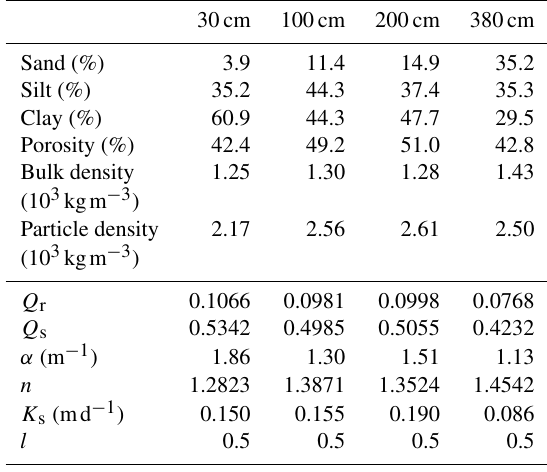
Table 2. Soil physical properties and van Genuchten parameters for four AGGO soil samples at different